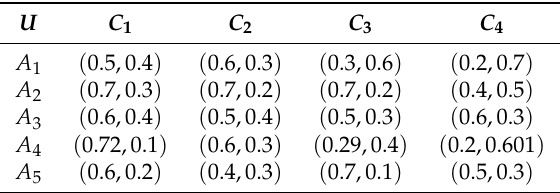
Table 5. Intuitionistic fuzzy soft set K = ( (cid:101) G , C ) .